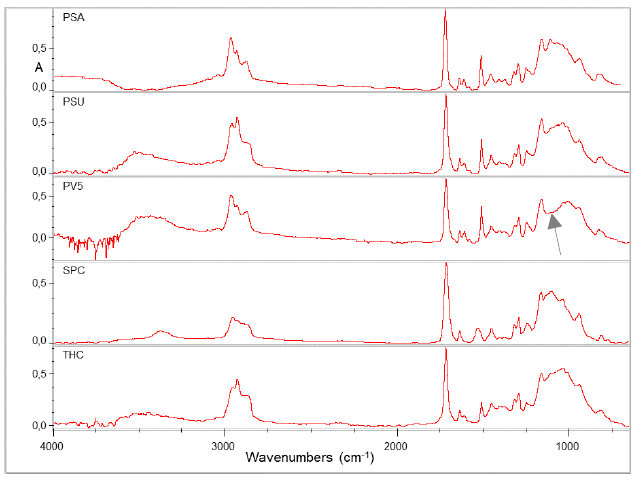
Figure 4. ATR-FTIR spectra of unset auto-mixed pastes of the materials tested. Arrow shows the absence of the P–O peak from the PV5 spectrum (4000–650 cm − 1 wavenumber range, A: Absorbance scale).